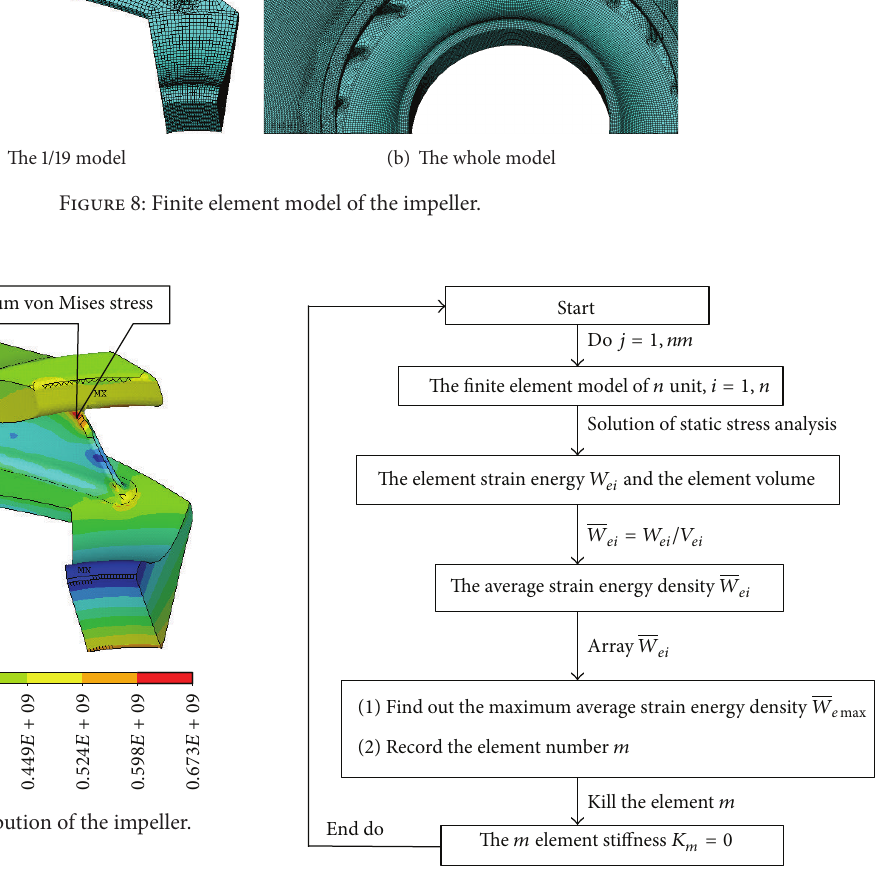
Figure 10: The numerical simulation process of crack